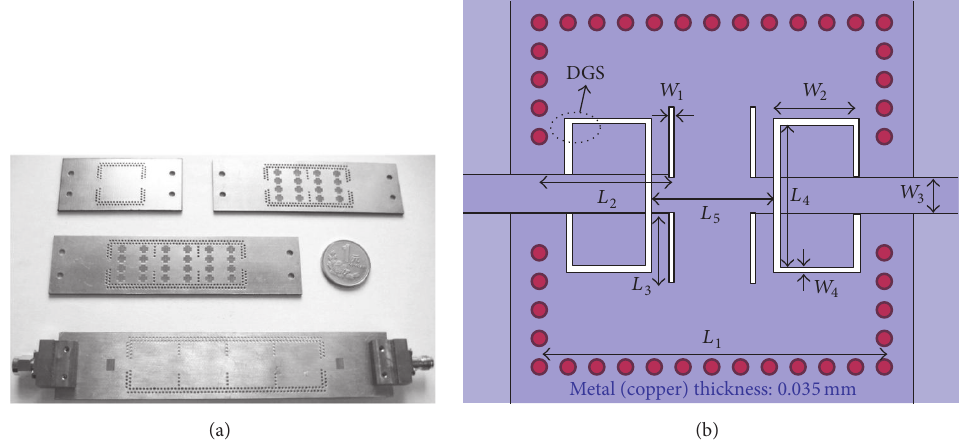
Figure 23: Coplanar waveguide with SIW technology embedded with DGS: (a) [55] and (b) [56].